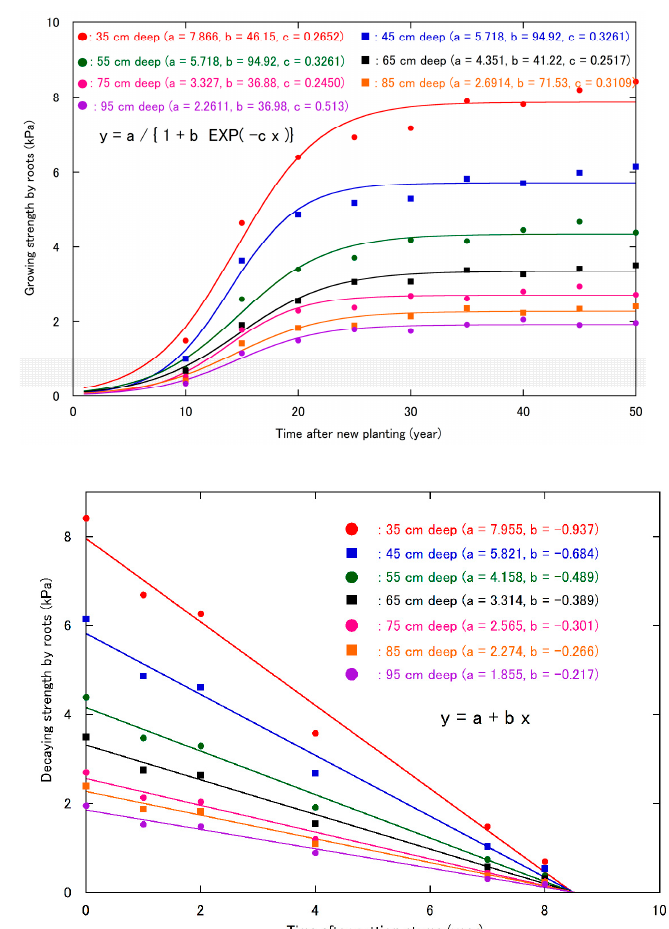
Figure 4. Changes in the reinforced strength of Japanese cedar roots over time. ( a ) Increased strength